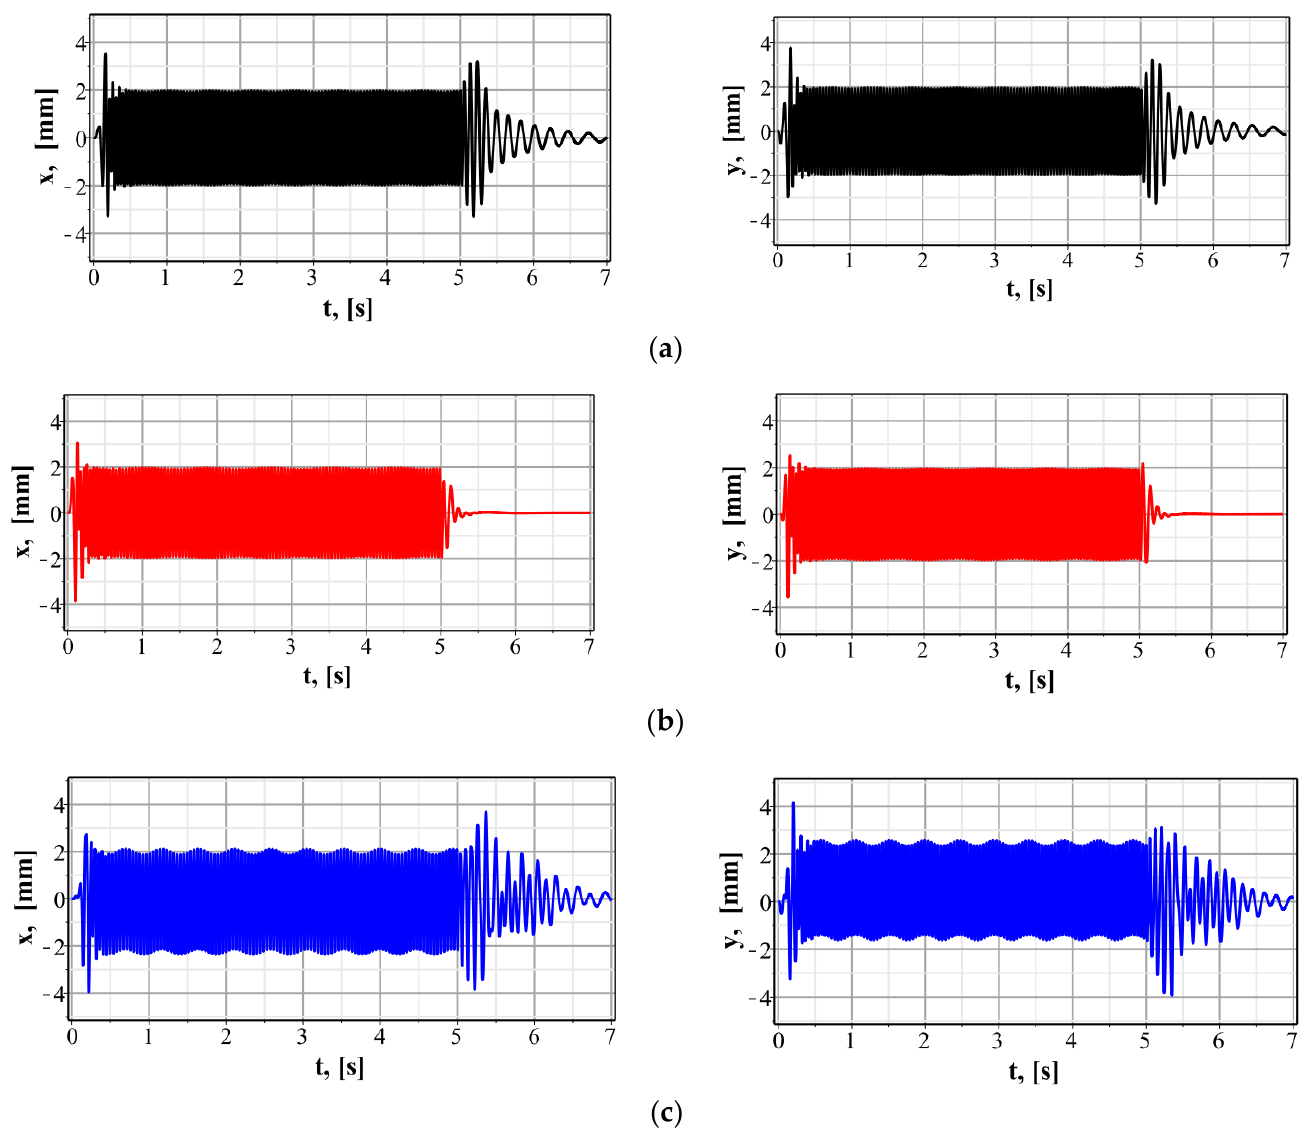
Figure 8. Time dependencies of the working member displacements at different synchronization conditions of the unbalanced rotors. ( a ) ω 2 = ω 1 ; ( b ) ω 2 = − ω 1 ; ( c ) ω 2 = 2 ω 1 . Table 3. Technical characteristics of the vibratory system.